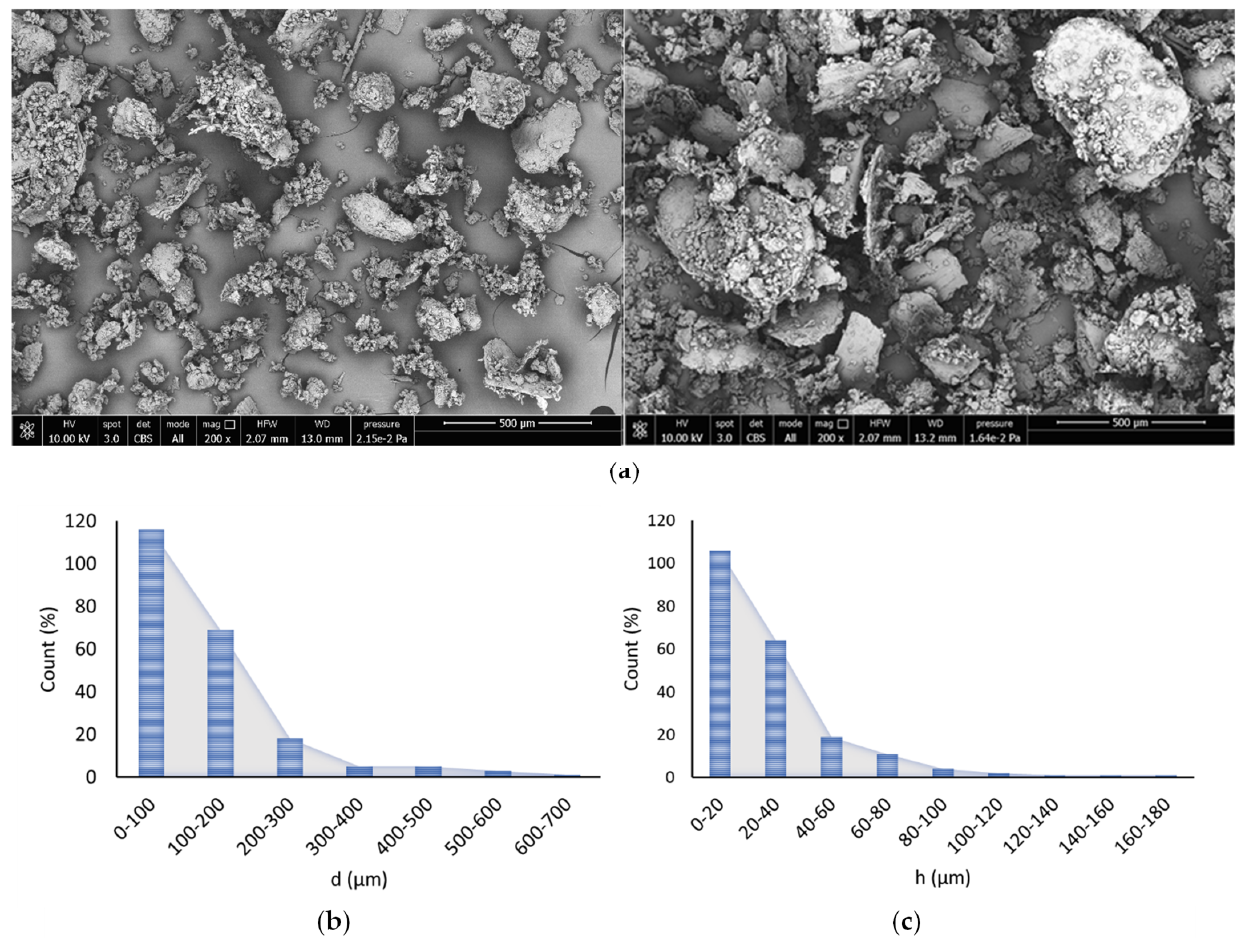
Figure 2. ( a ) SEM images at 200 × of wheat bran fibers ( b ) average diameter distribution and ( c ) average thickness distribution.